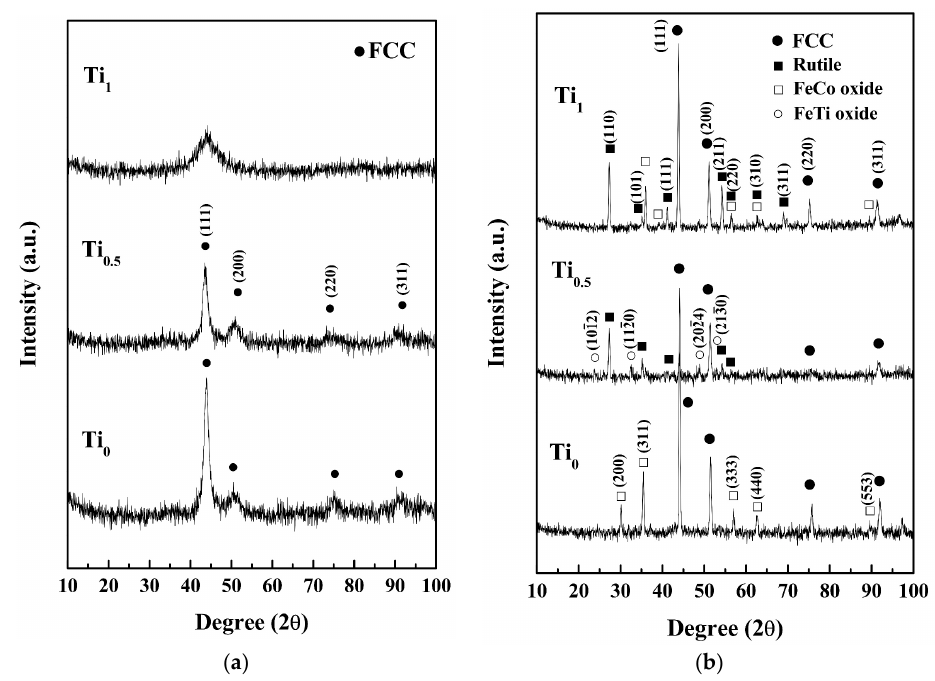
Figure 2. Glancing incident angle XRD patterns of ( a ) as-deposited; and ( b ) as-annealed Ti x FeCoNi films. Table 2. Chemical compositions of as-deposited Ti x FeCoNi thin films (SEM/EDS).